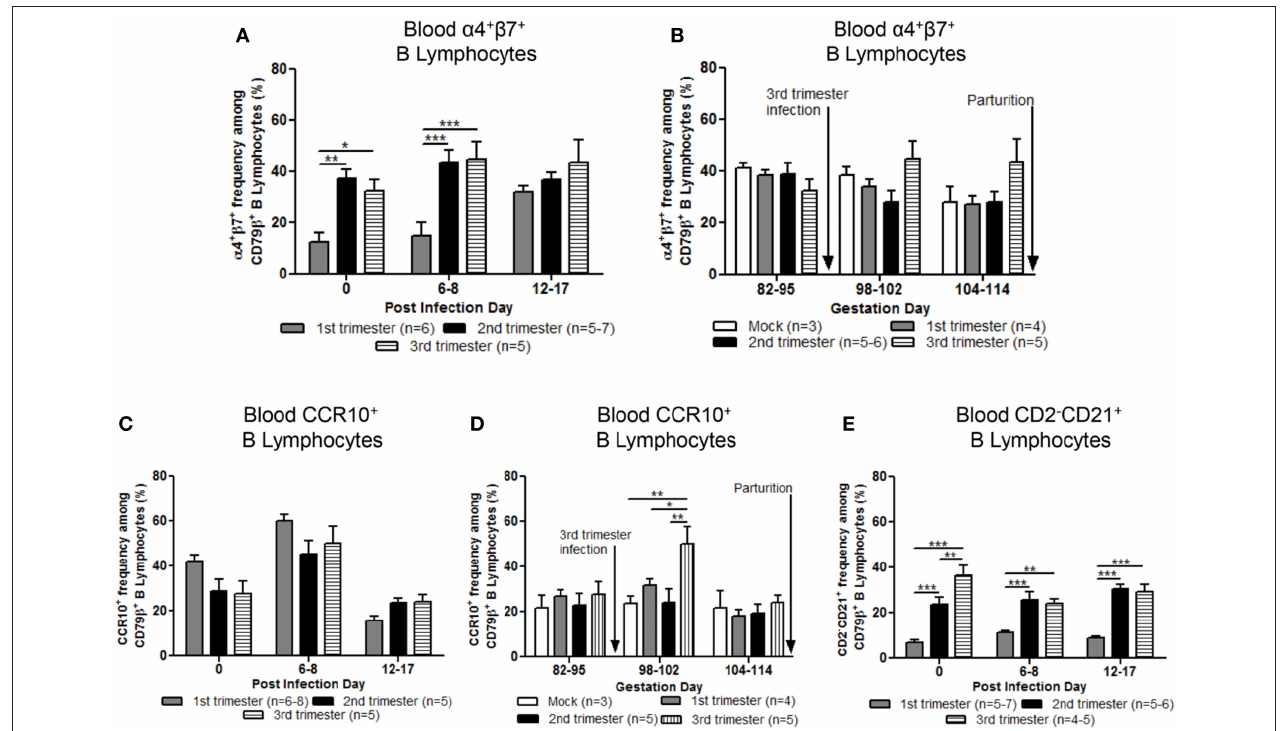
FIGURE 6 | Stage of gestation modulated circulating frequencies of B cell phenotypes prepartum . Peripheral blood mononuclear cells (MNCs) were isolated and analyzed at post infection day (PID) 0, 6–8 and 12–17 and gestation day (GD) 82–95, 98–102, and 104–114 for mean frequencies of α 4 + β 7 + (A,B) and chemokine receptor type 10 (CCR10 + ) (C,D) B cells. Additionally, (E) primed and/or activated B lymphocytes (CD2 − CD21 + ) were analyzed at PID 0, 6–8, and 12–17. Asterisks indicate significant differences among treatment groups at the same time point (mean ± SEM). Statistical analysis was performed using the two-way ANOVA with repeated measures and Bonferroni’s correction for multiple comparisons. * P < 0.05, ** P < 0.01, *** P <